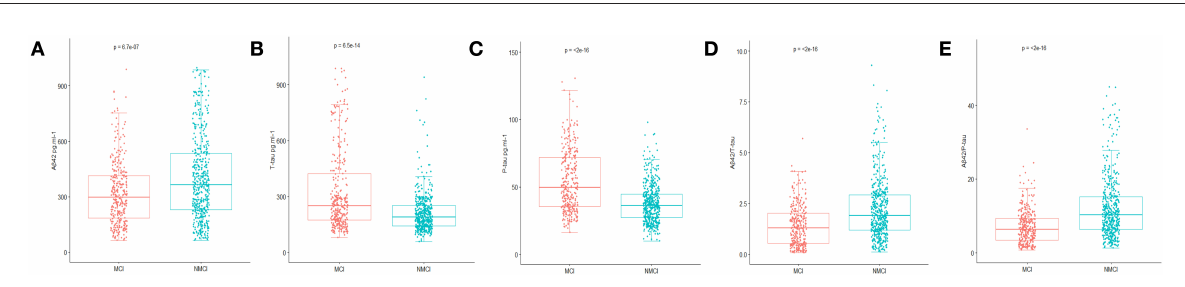
FIGURE2 Distribution of CSF biomarkers levels for participants with and without MCI. (A) The concentrations of amyloid β 42 (A β 42 ) decreased in MCI patients compared with NNMCI patients. (B) Total-tau (T-tau) increased in MCI patients compared with NNMCI patients. (C) Phosphorylated total-tau (P-tau) increased in MCI patients compared with NNMCI patients. (D) Amyloid β 42 / Total-tau (A β 42 / T-tau) decreased in MCI patients compared with NNMCI patients. (E) Amyloid β 42 / phosphorylated total-tau (A β 42 / P-tau) decreased in MCI patients compared with NNMCI patients. P -values were assessed by Student’s T